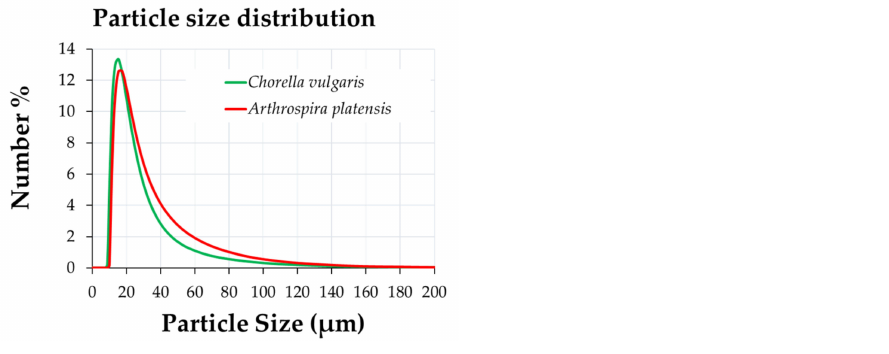
Figure 2. Particle-size distribution of biomass powders used (green: Chlorella vulgaris ; red: Arthrospira platensis ).